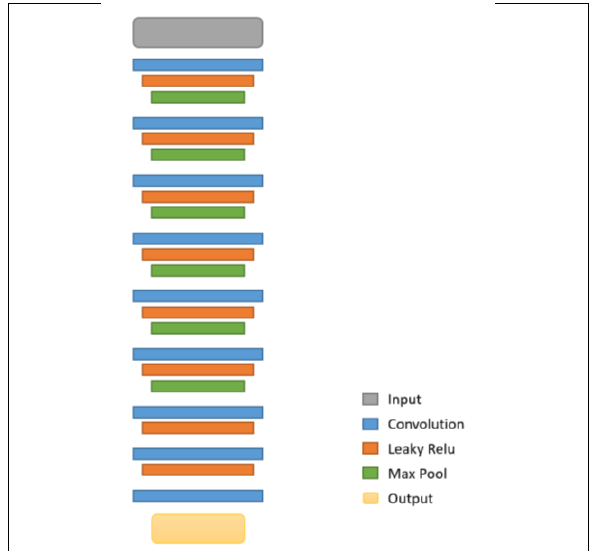
Figure 2. Architecture of the detection network